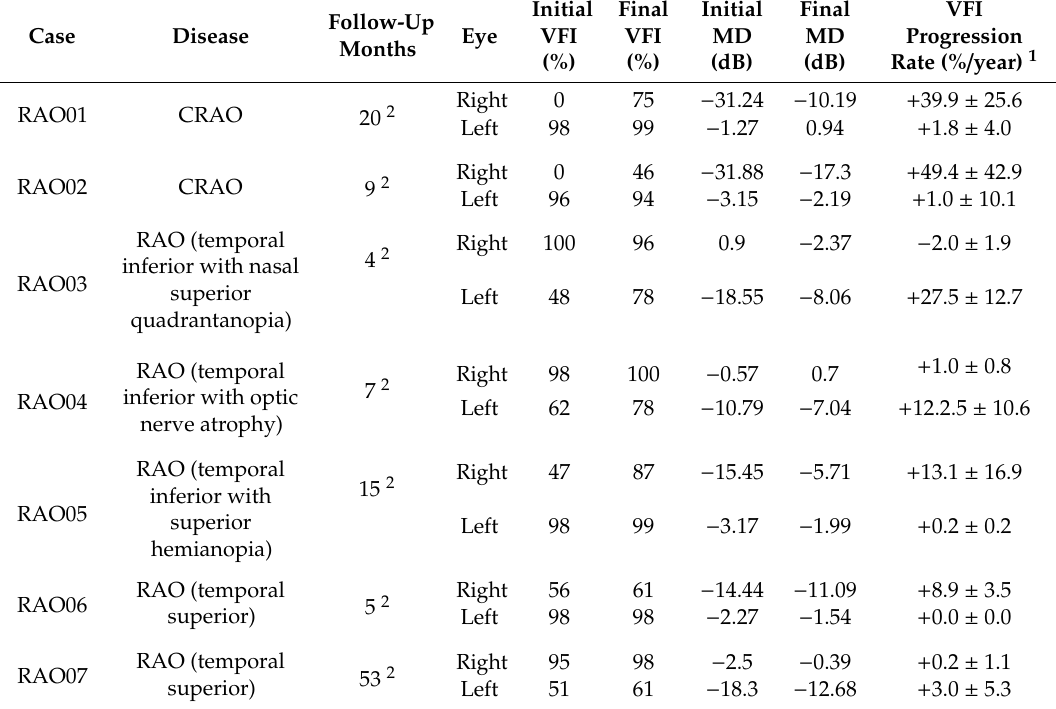
Table 4. Clinical characteristics of RAO patients, VFI and MD follow-up, and progression rate.